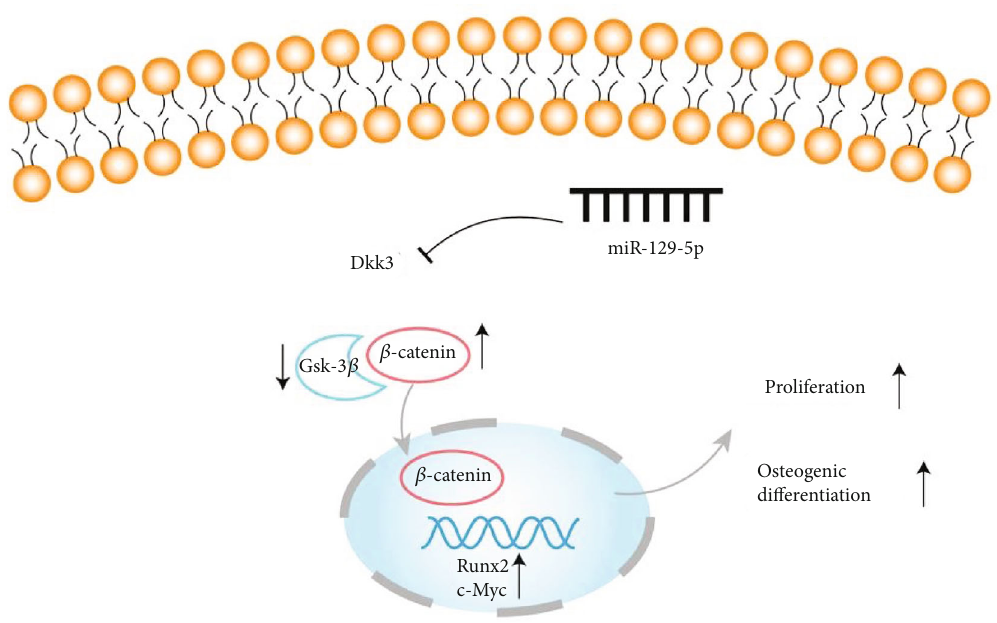
Figure 10: Schematic diagram of miR-129-5p/Dkk3 axis in osteogenic di ff erentiation of